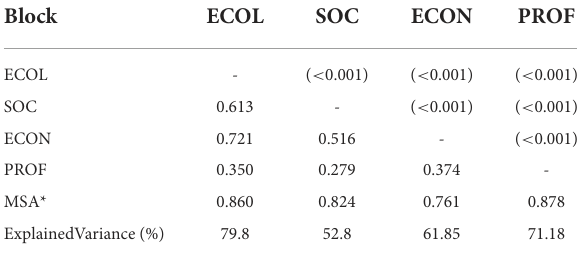
TABLE 4 Squared correlations of CATPCA components.